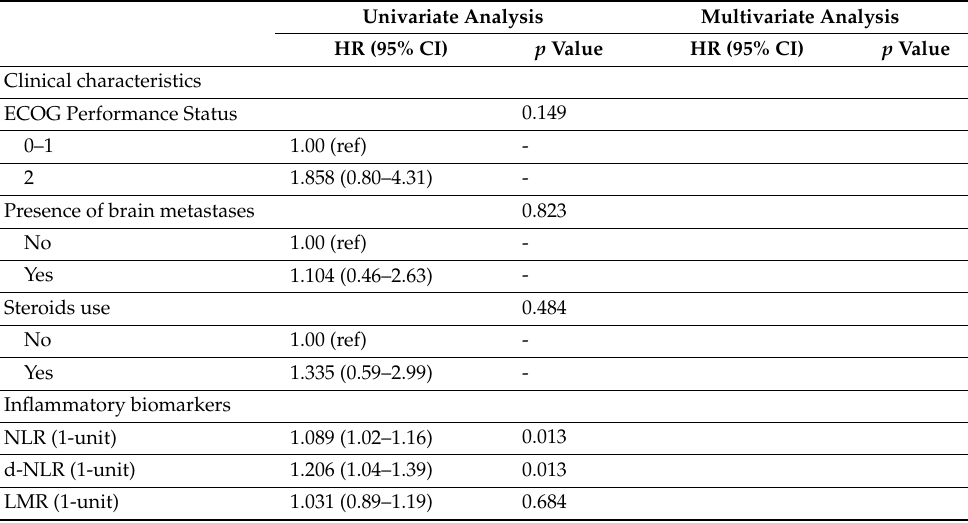
Table 2. Clinical characteristics, systemic inflammation, and FDG PET/CT parameters at radiologi- cal progression.